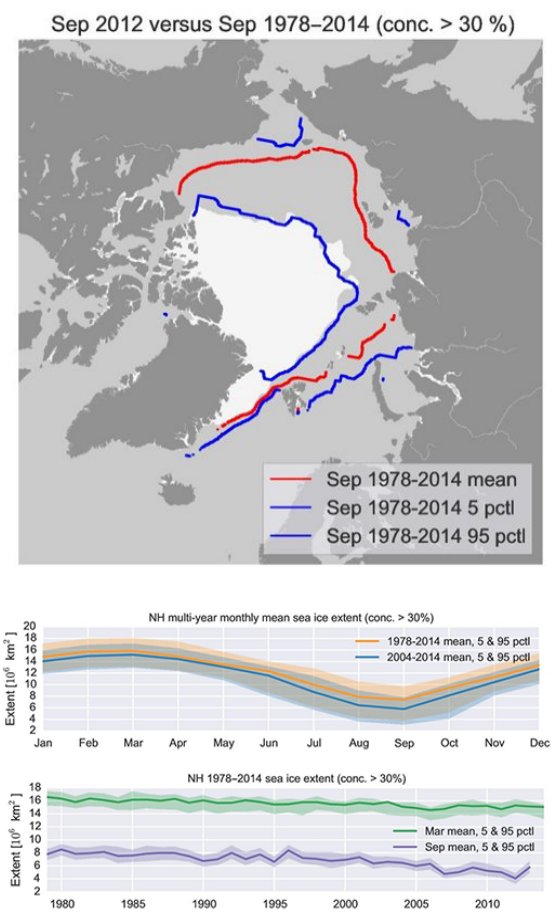
Figure 10. The upper panel: the September 2012 sea ice extent in the Arctic compared to the mean extent shown with the red line. The blue lines on either side of the mean extent line (red) are the 5 and 95 percentiles of ice extent. The lower two panels show the annual cycle of sea ice extent. The shaded areas are the 5 and 95% percentiles of the interannual and daily variability respectively. The lower panel show the long-term (1978–2014) Arctic sea ice extent near its maximum in March and near its minimum in September.